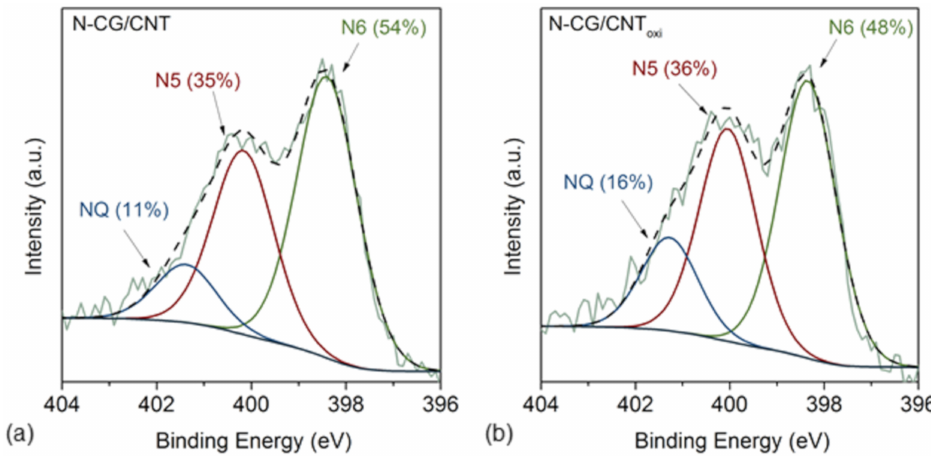
Figure 4. XPS spectra of N1s for N-doped composites N-CG / CNT ( a ) and N-CG / CNT oxi ( b